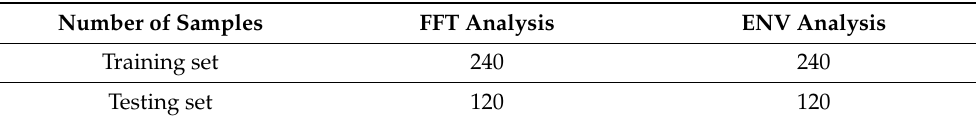
Table 2. The structure of the training and testing data with the division into the fast Fourier transform (FFT) and envelope analysis (ENV) of the vibration signal.